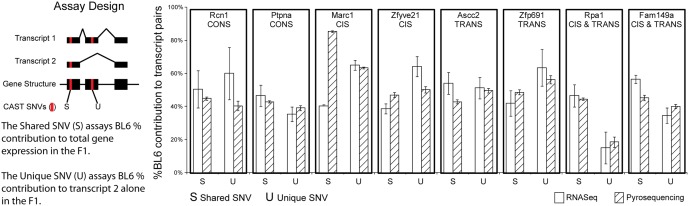
Allele-specific isoform divergence was validated pyrosequencing in the F1.The contribution of the BL6 allele to gene and transcript expression in the F1 hybrids was validated by site-specific pyrosequencing. For each of the eight genes tested, two independent SNVs were assayed: one SNV measured the contribution of the BL6 allele to total gene expression (S), the other assayed the BL6 contribution to one of the two expressed transcripts (U). The pyrosequencing results measuring BL6 contribution to total gene expression (S) and to transcript 2 only (U) should both be in agreement with the RNASeq/MMSeq Expression Estimates. Good agreement was observed for 7 of the 8 genes (Rcn1, Ptpna, Zfyve21, Ascc2, Zfp691, Rpa1, Fam149a).